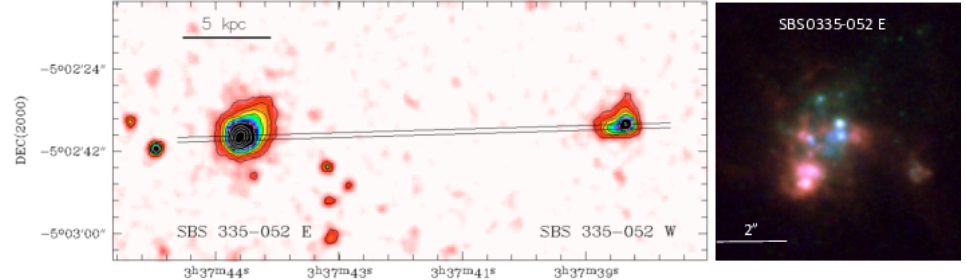
Figure 6. Left : A B-band image taken from the Calar Alto observatory showing the western and eastern components of SBS0335–052. The black lines indicate the location of a slit used for optical and near infrared spectroscopy. Taken from [60]. Right : A composite true-color HST/ACS image of SBS0335–052 that illustrates the super star clusters in the eastern source. Taken from [170].